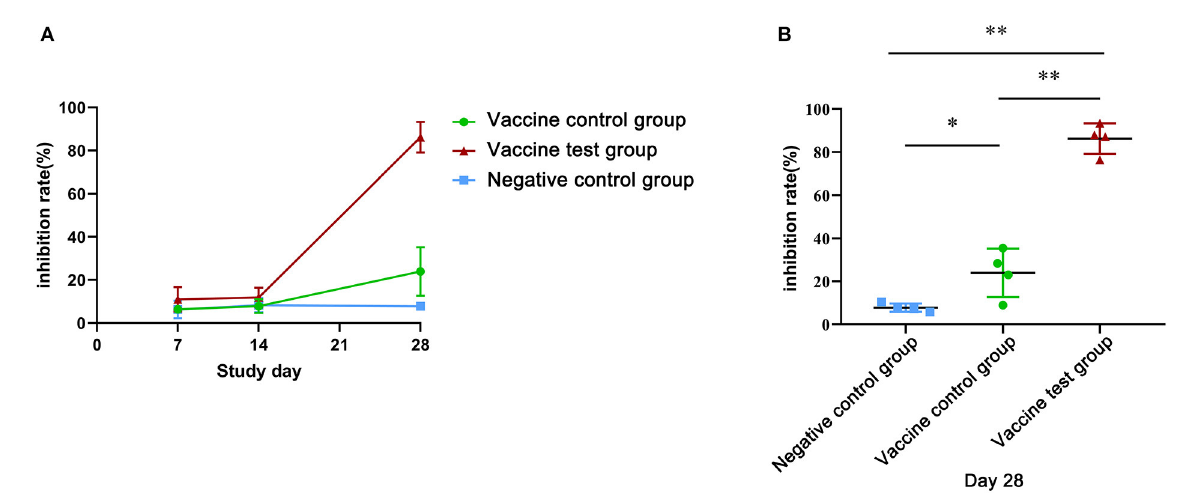
FIGURE3 Inhibition rates of neutralizing antibodies blocked the SARS-CoV-2 (B.1.617.2) spike protein binding to ACE2. (A) Inhibition rates of mice serum neutralizing antibodies in three groups at day 7, 14, and 28. (B) The comparison of inhibition rates of neutralizing antibodies in the three groups on day 28 (Vaccine test group, n = 4; Vaccine control group, n = 4; Negative control group, n = 4; * p < 0.05; ** p < 0.01; p < 0.05 was considered statistically